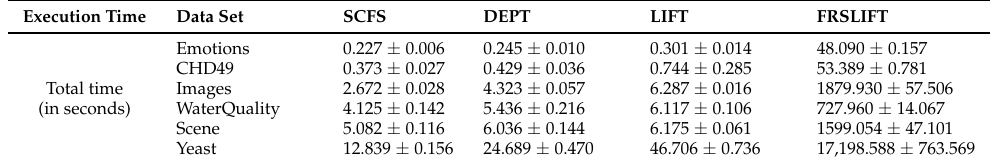
Table 6. Execution time of four compared algorithms (mean ± std) on 6 regular-scale data sets.